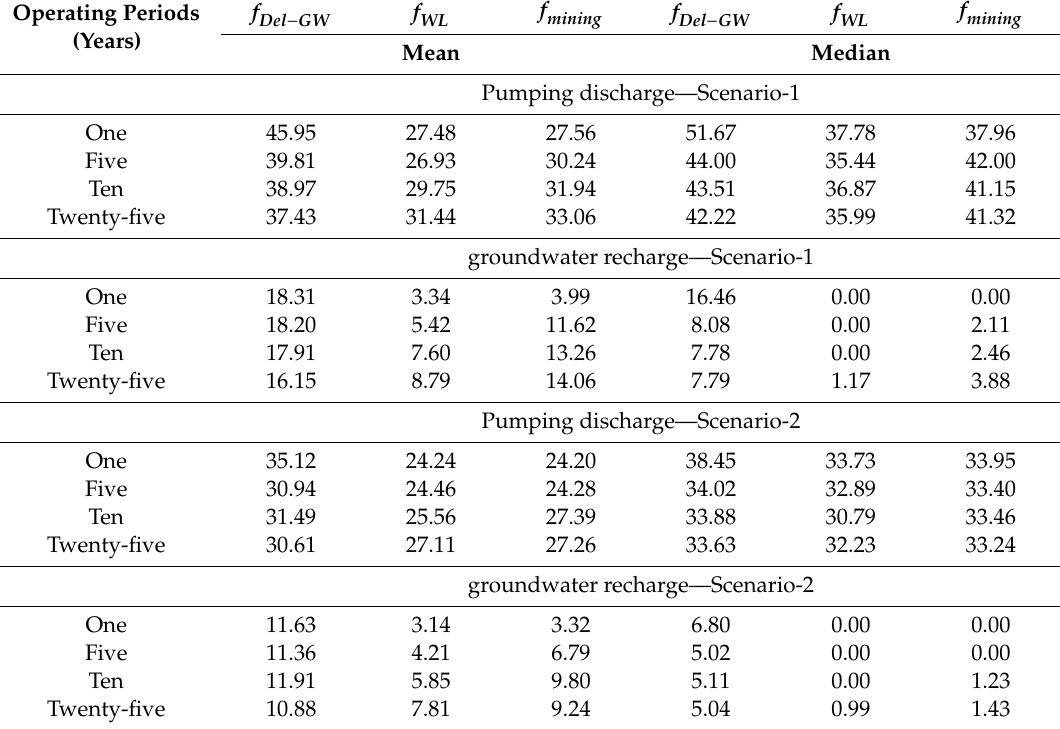
Figure 7. Final groundwater storage achieved by optimization model for open furrows and drip irrigation system over the adopted discrete periods. Table 6. Summary of pumping discharges and aquifer recharges for the optimum solution achieved by each objective function over considered periods using open furrows and drip irrigation system (m 3 / month × 10 6